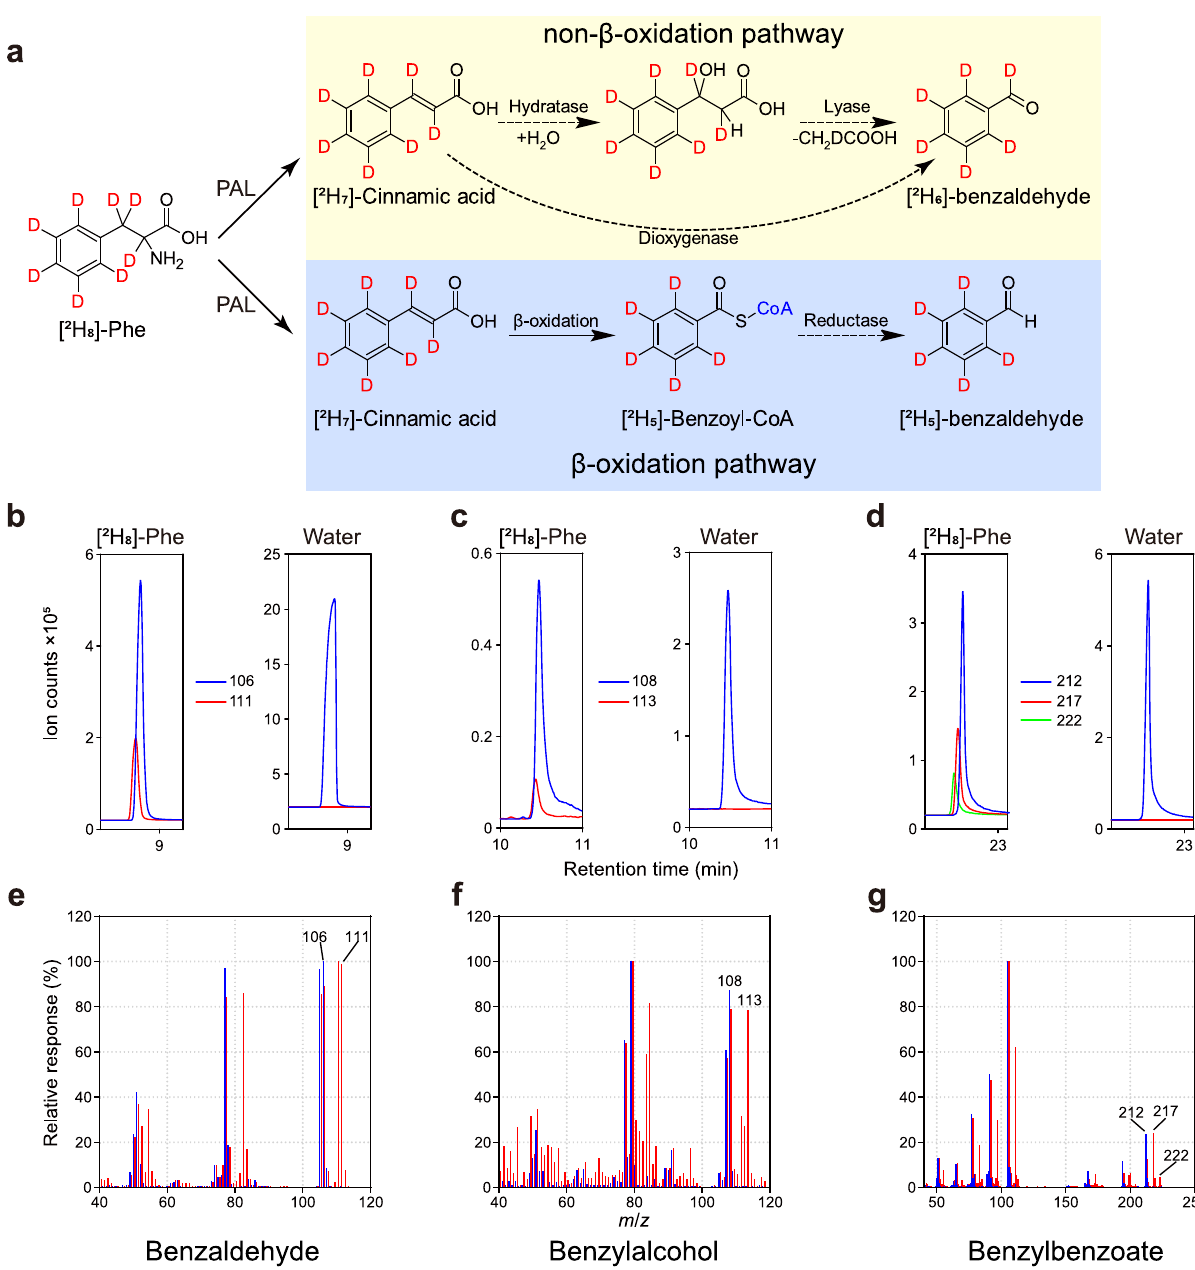
shown by dashed arrows. PAL, phenylalanine ammonia lyase. b – d GC – MS chromatogram of benzaldehyde ( b ), benzylalcohol ( c ) and benzylbenzoate ( d